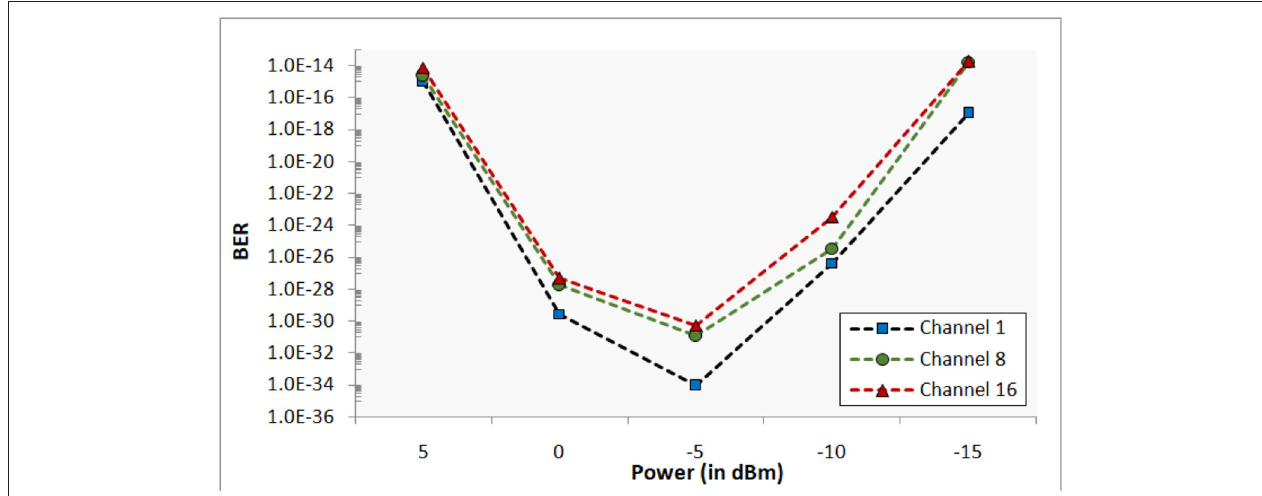
FIGURE 13 | Variation of BER with power at channel spacing of 100 GHz.